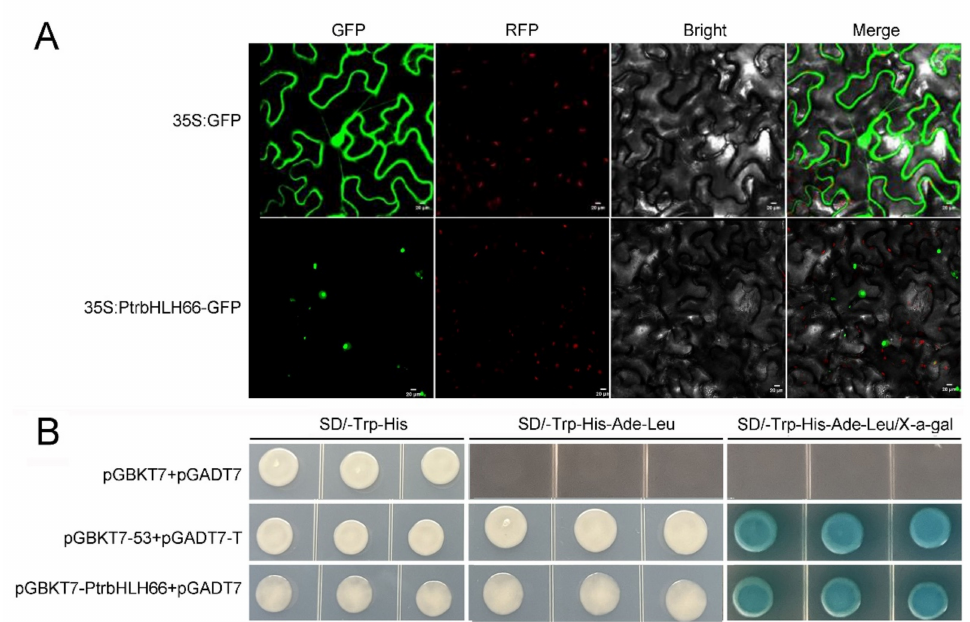
Figure 2. Subcellular localization and transcriptional activation analysis of PtrbHLH66. ( A ) Sub- cellular localization of PtrbHLH66 protein. The fluorescence signals of 35S:GFP (control) and 35S:PtrbHLH66-GFP proteins in epidermal cells of Nicotiana benthamiana leaves were observed with confocal microscopy. The confocal images were taken under GFP, RFP, bright light and merged fields, respectively. Bars represent 20 µ m. ( B ) Transcriptional activation activity analysis of PtrbHLH66. The CDS sequence of PtrbHLH66 was introduced into the pGBKT7 vector to generate the fusion plasmid of pGBKT7-PtrbHLH66. Two pairs of plasmids (pGBKT7 and pGADT7, pGBKT7-53 and pGADT7-T) were co-transformed into Y2HGold yeast cells and used as negative control and pos- itive control, respectively. Yeast cells were grown on SD/-Trp-His, SD/-Trp-His-Ade-Leu, and SD/-Trp-His-Ade-Leu/X-a-gal